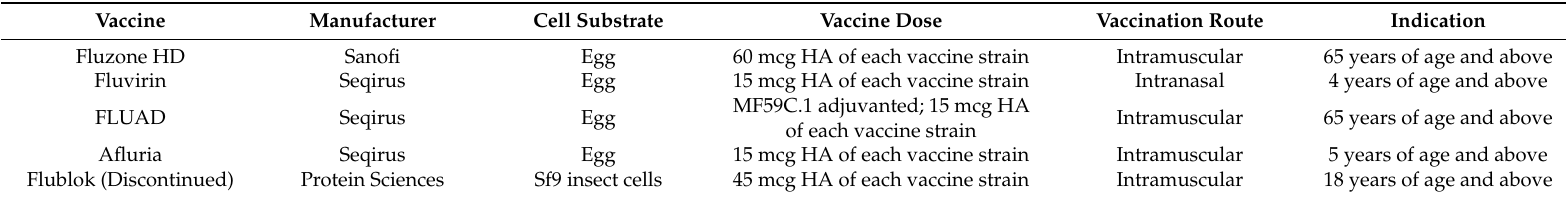
Table 2. Trivalent Influenza Vaccines (TIV) licensed in the United